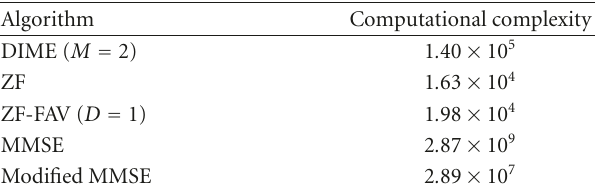
Table 2: Computational